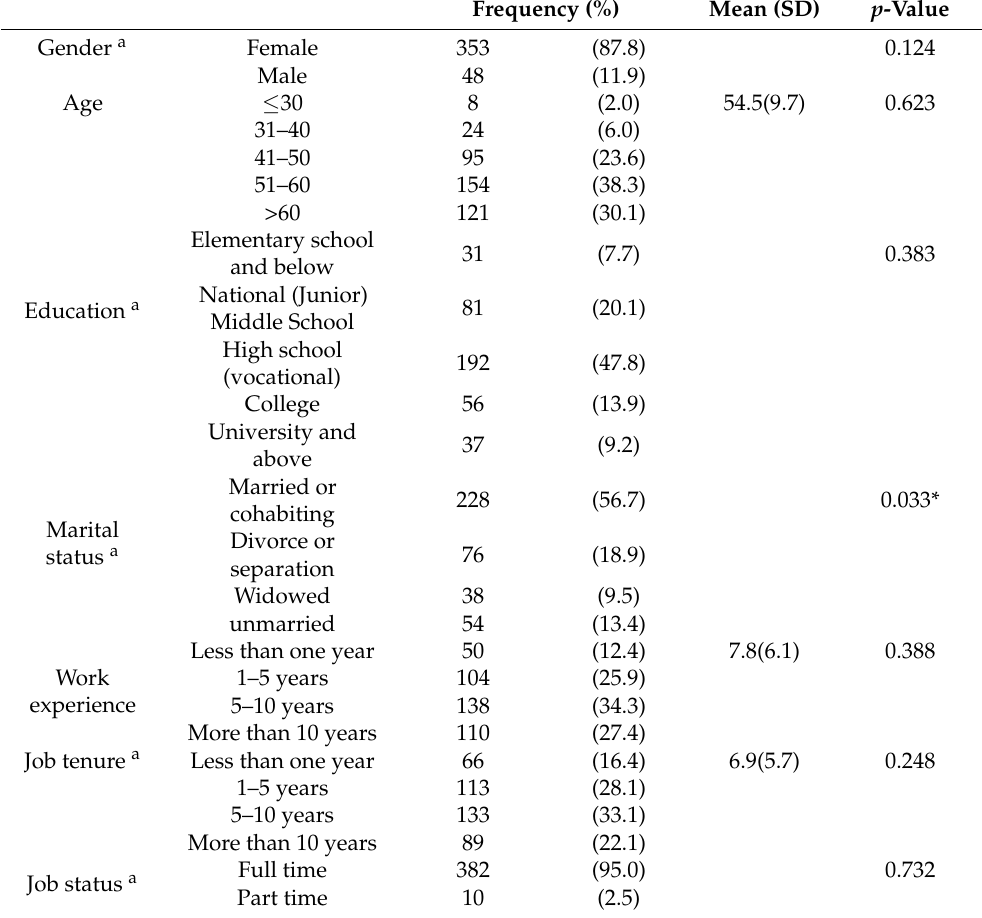
Table 1. Analysis of the difference between personal characteristics and turnover intention ( n = 402).